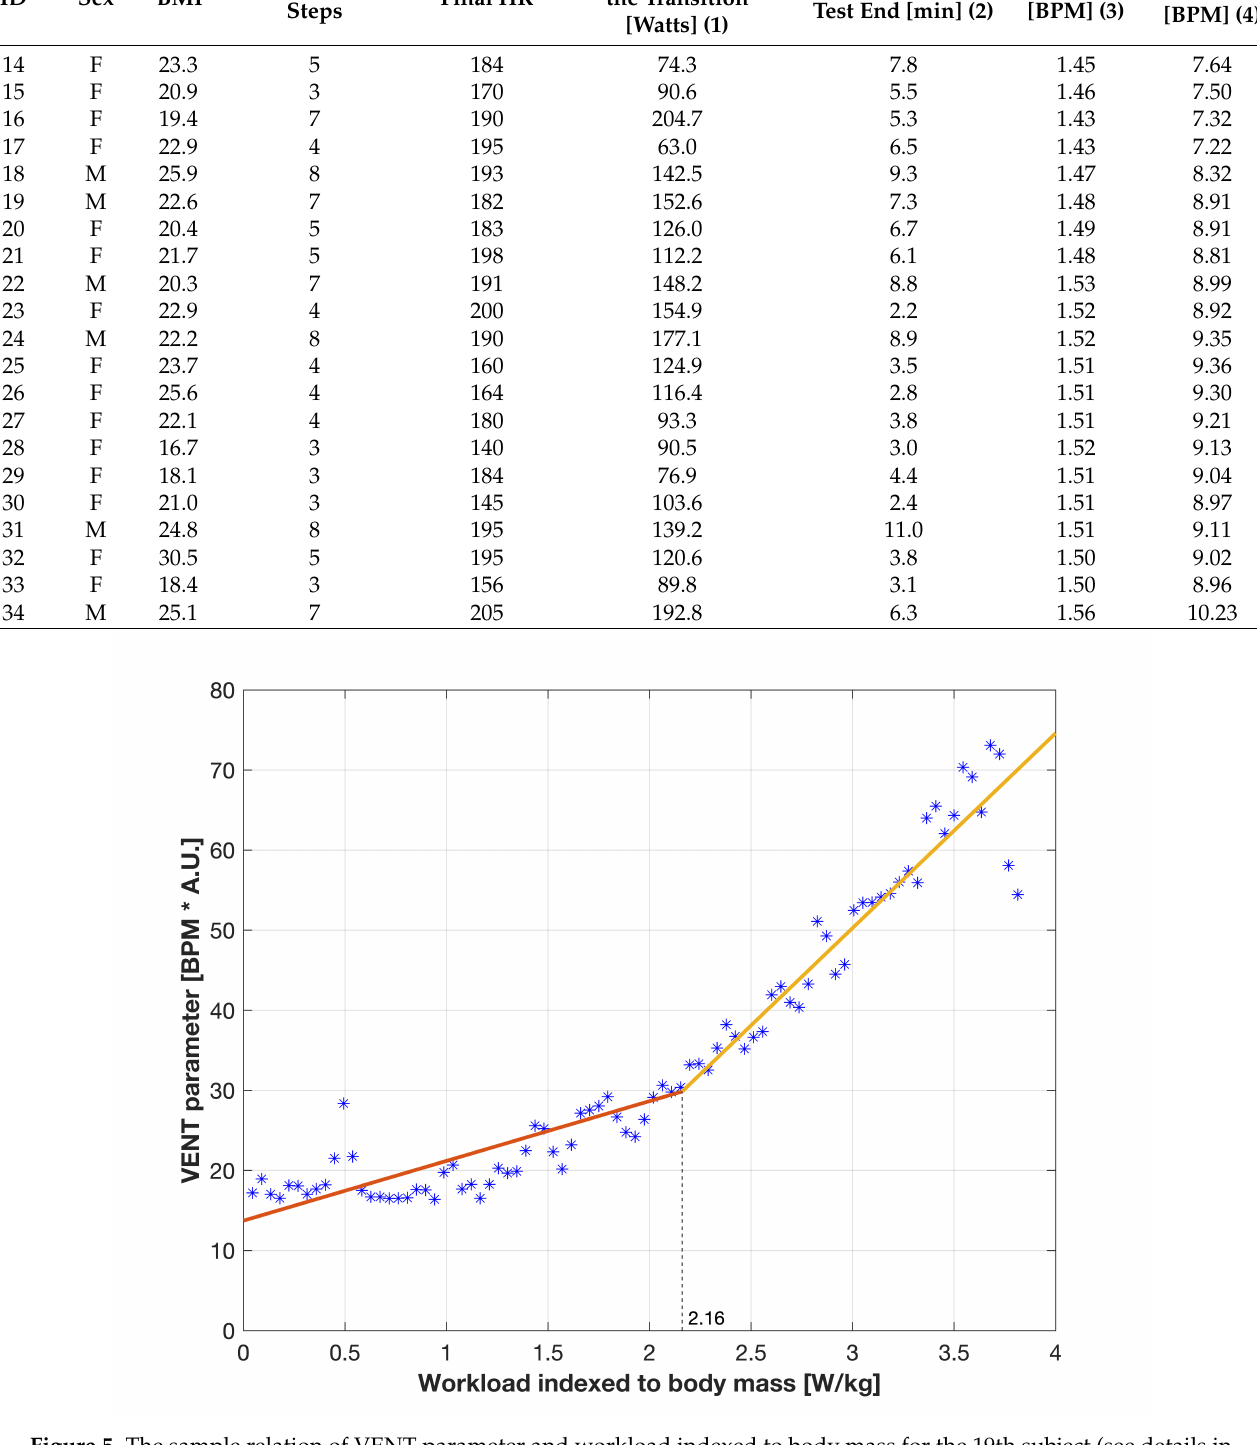
Figure 5. The sample relation of VENT parameter and workload indexed to body mass for the 19th subject (see details in the text) with the linear models providing the estimated transition point. The left one can described by: VENT = 7.46 × WLiBM + 13.73; the right one by: VENT = 24.33 × WLiBM − 22.70, where WLiBM is workload indexed to body mass. The independent variable is linearly distributed, as described in Section